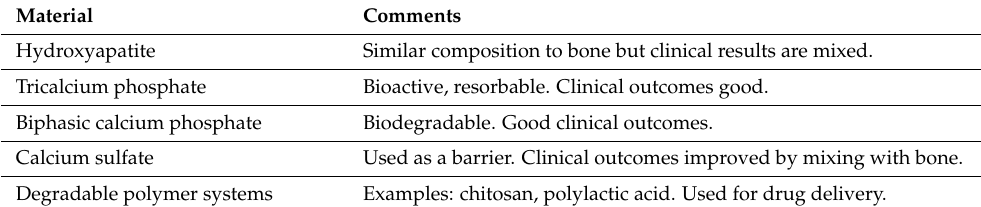
Table 2. Materials other than bioactive glass used in periodontal